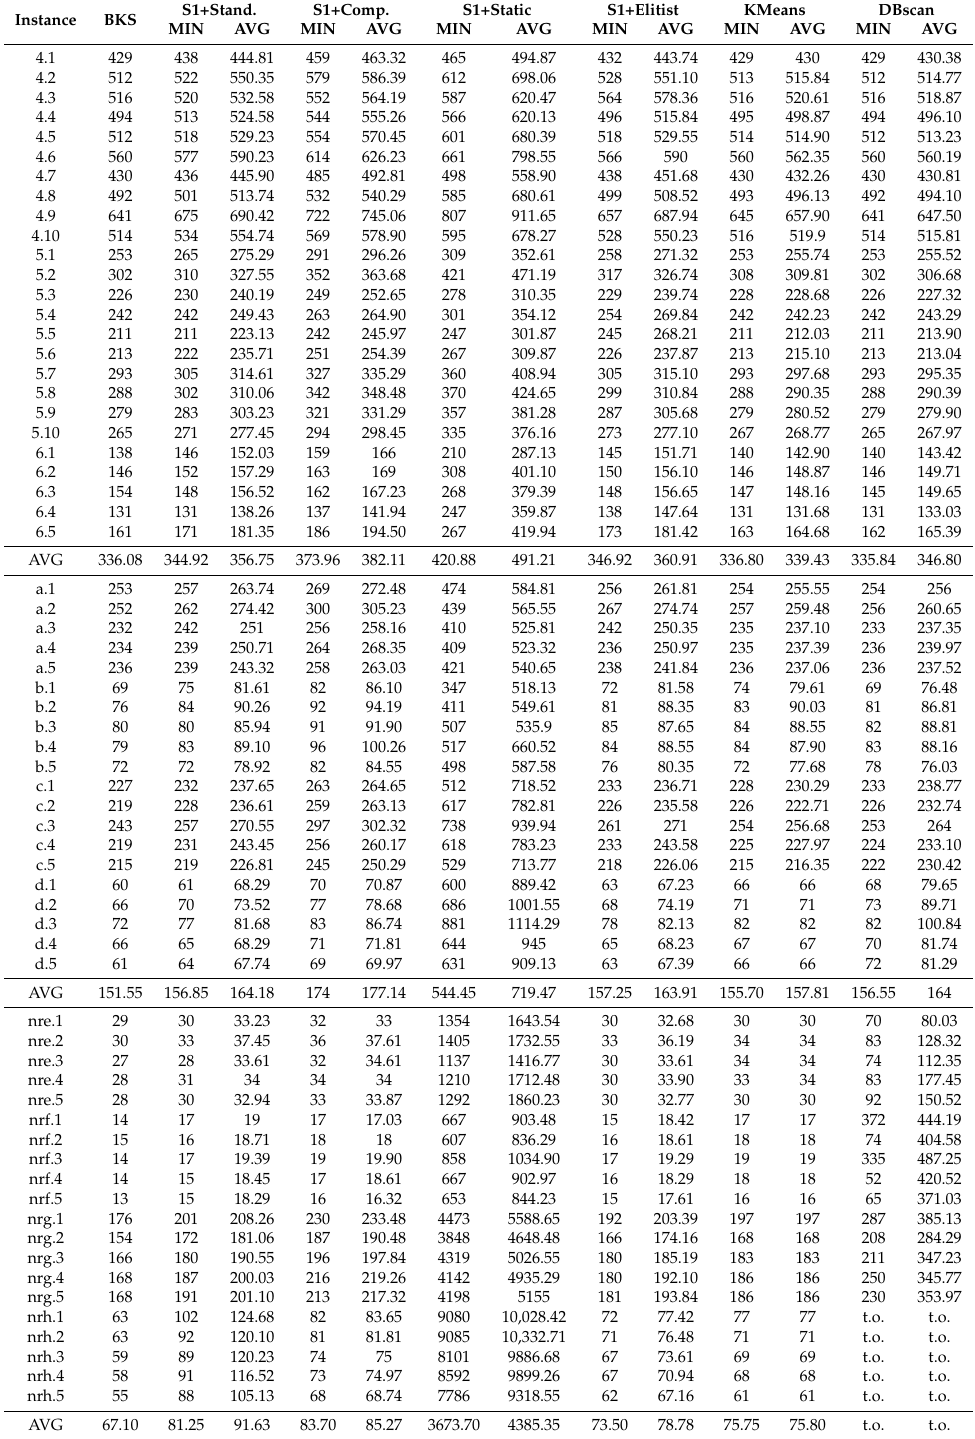
Table A1. CSA/SCP—SShape 1—Two-steps vs. KMeans vs. DBscan (t.o = time